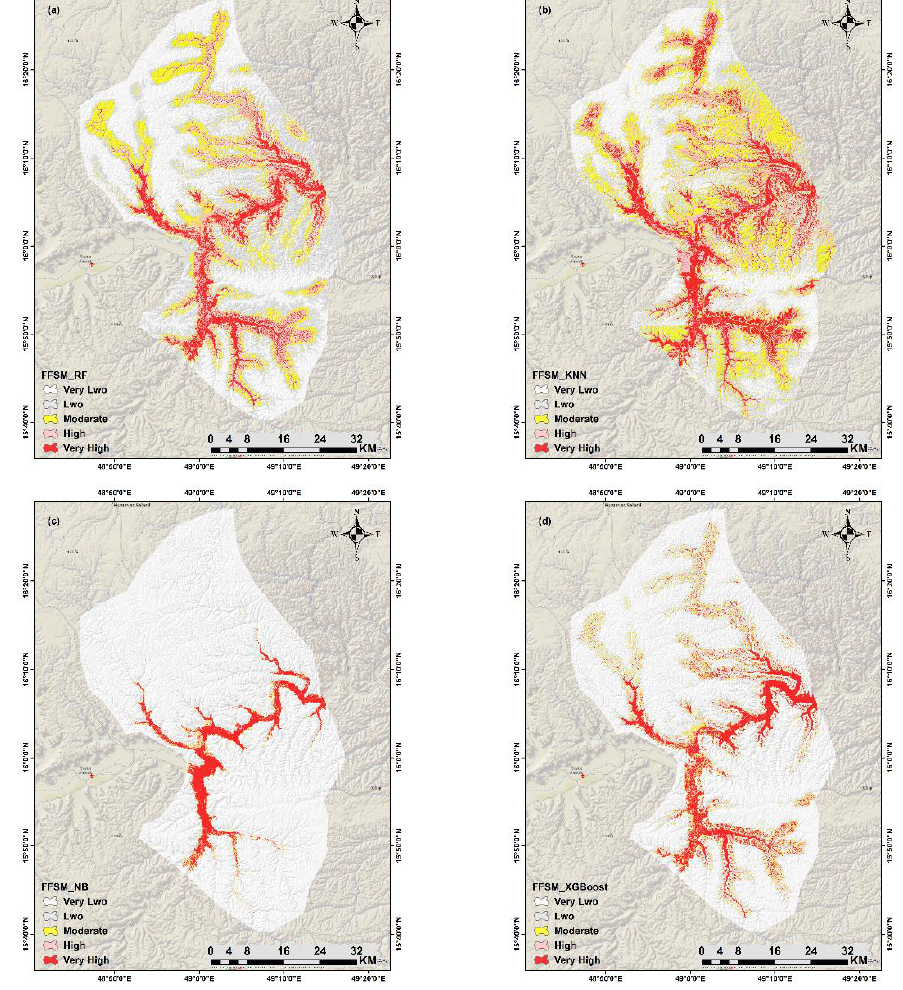
Figure 11. FFS maps of the RF ( a ), KNN ( b ), NB ( c ), and XGBoost ( d ) models.